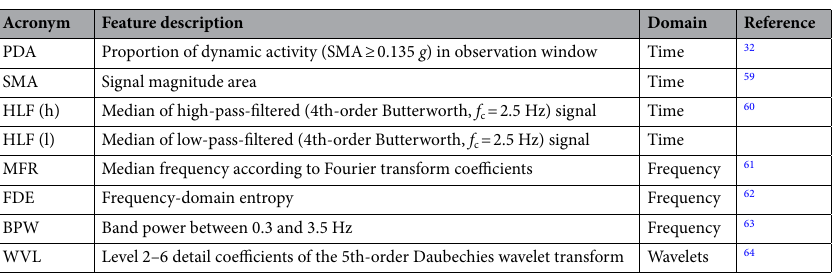
Table 3. Overview of extracted motion feature types. Each feature, except PDA, was extracted from non- overlapping 5 s windows and root-sum-of-squares leveled across the three axes of accelerometry measurement (x, y, z). A single PDA value was calculated per each sensor for the entire observation window. f c represents the critical frequency of the Butterworth filter. The references point to original works in which the features (or similar variants) were used in physical activity recognition. Explicit formulae for each feature can be found in “Methods” section.